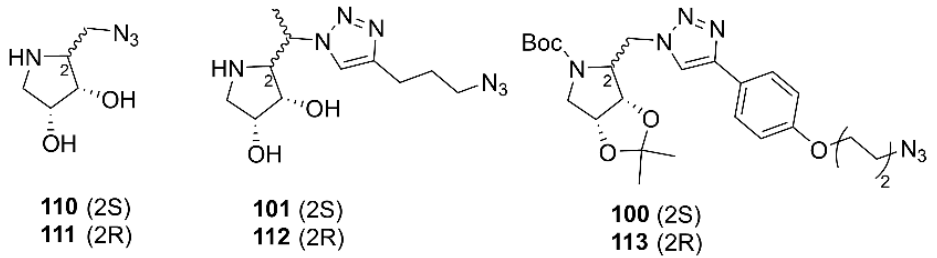
Figure 7 . Azidoalkyl pyrrolidines used as anchoring moieties. Figure 7. Azidoalkyl pyrrolidines used as anchoring